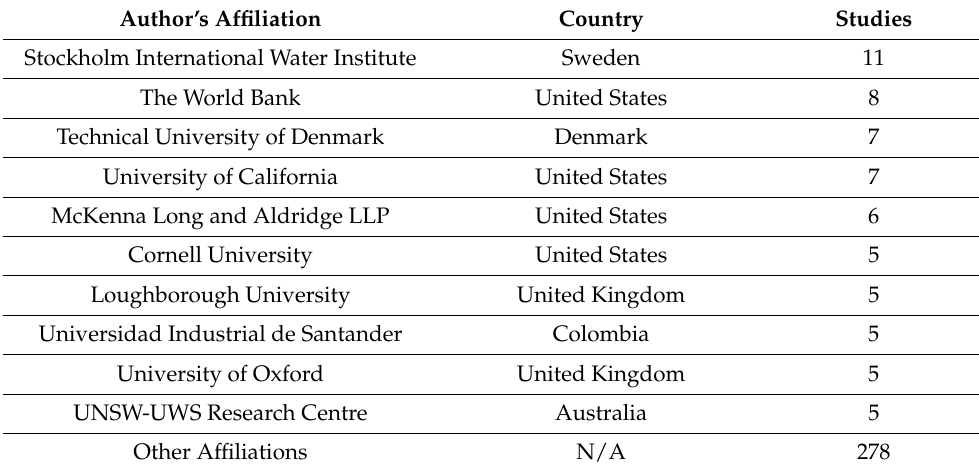
Table 4. Publications according to authors’ affiliations and